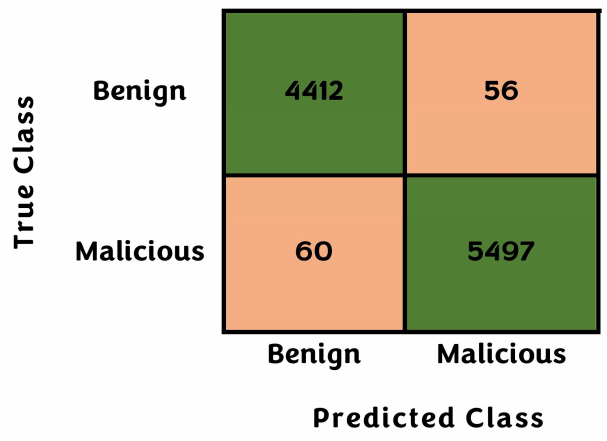
Figure 8. Binary confusion matrix